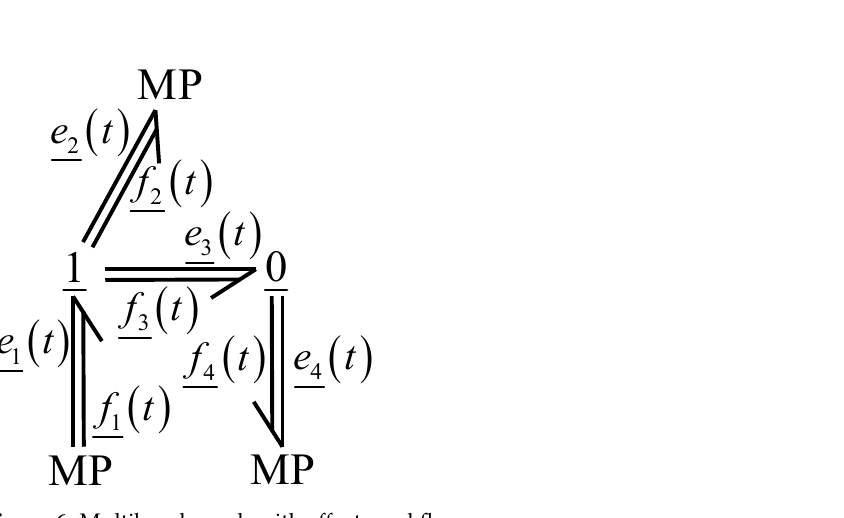
Figure 6. Multibond graph with efforts and flows.